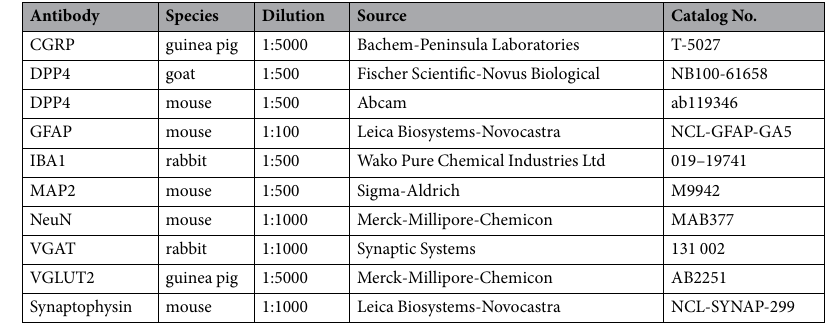
Table 2. Specifications of primary antibodies used for